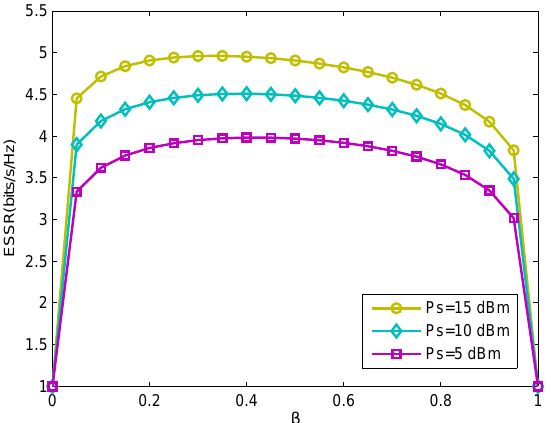
Figure 2. ESSR versus power allocation ratio β .